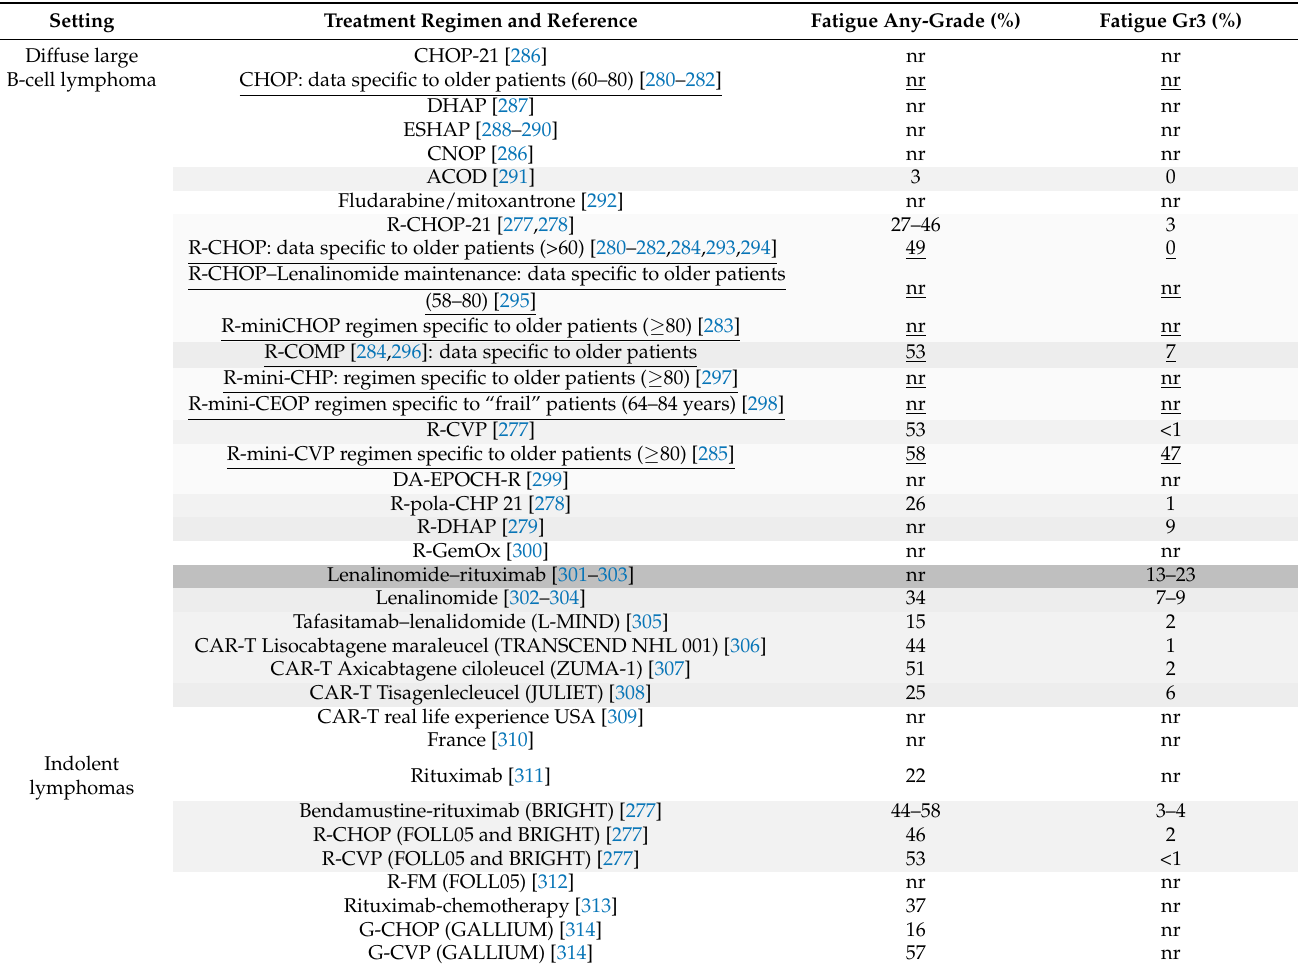
Fatigue events in the most common anticancer regimens for non-Hodgkin’s and follicular